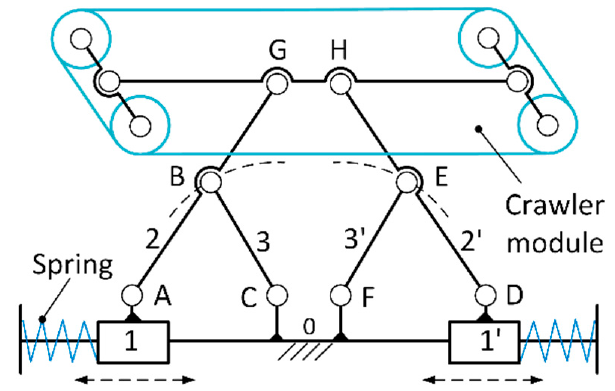
Figure 9. Adapting mechanism with crawler